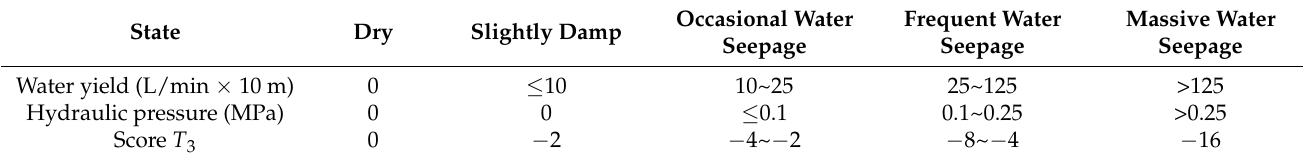
Table 8. Score of middle rock pillar permeability.